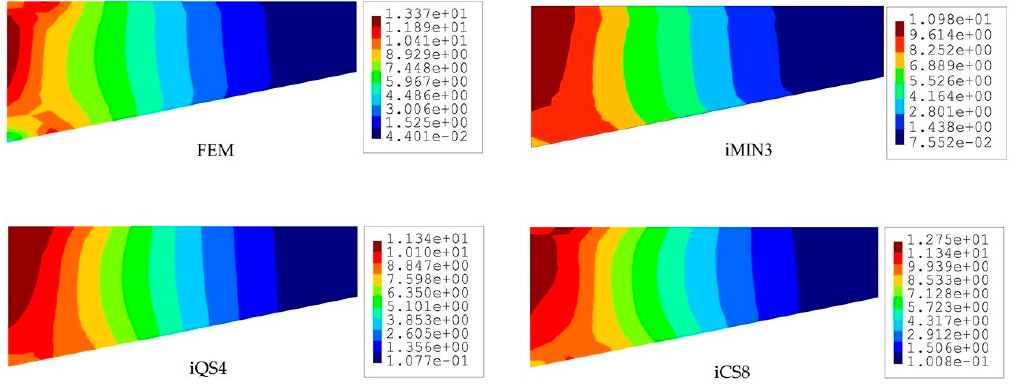
Figure 5. Contours of von Mises stress [MPa] for the tapered plate.